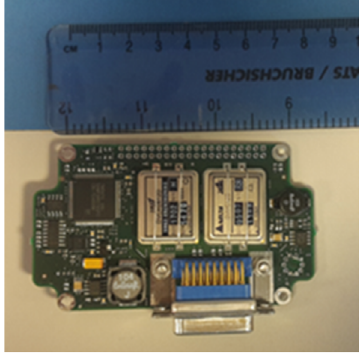
Fig. 10. Showing a RadMon 3.0 engineering model, for CIRCE